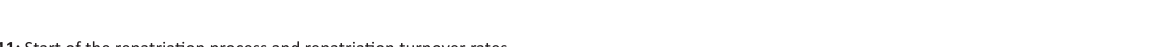
TABLE 11: Start of the repatriation process and repatriation turnover rates. Correlations (Spearman’s rho)